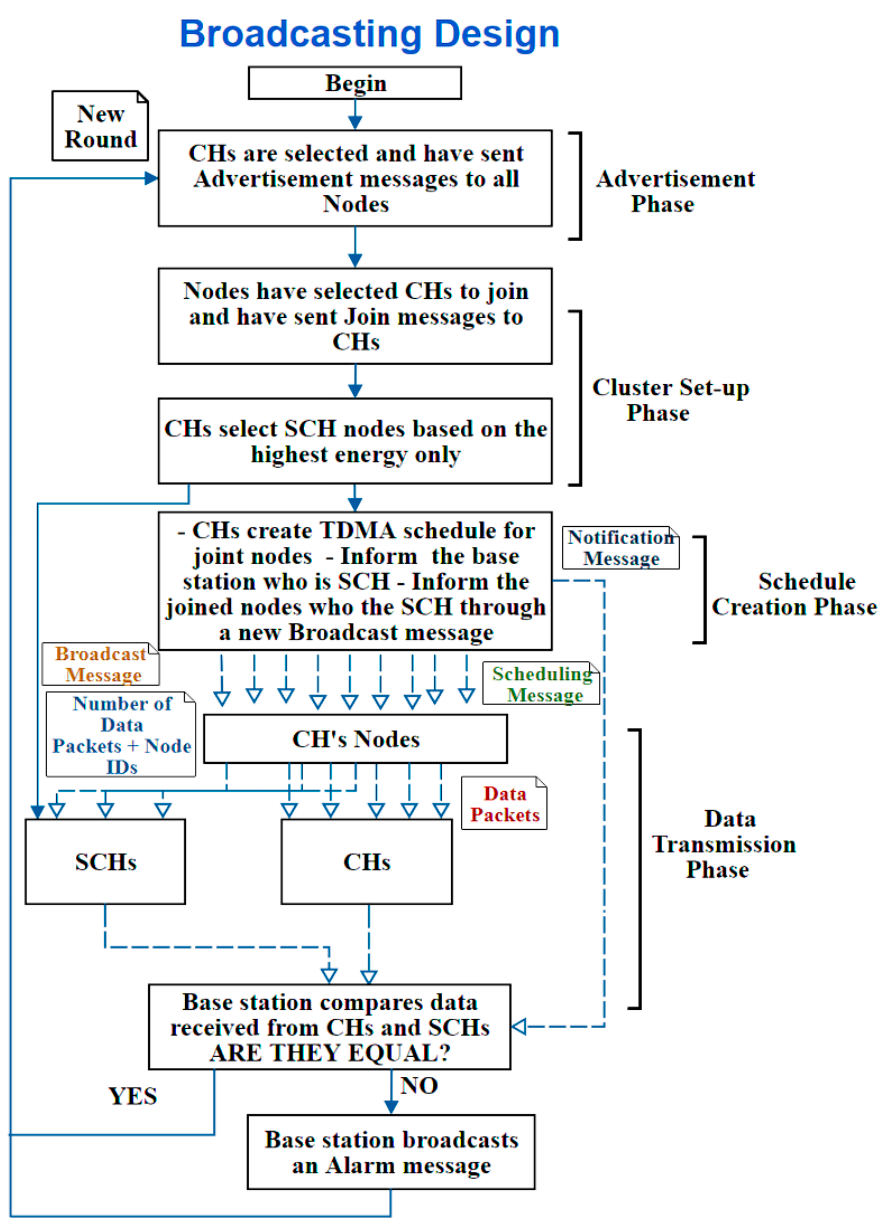
Figure 7. Broadcast design process.